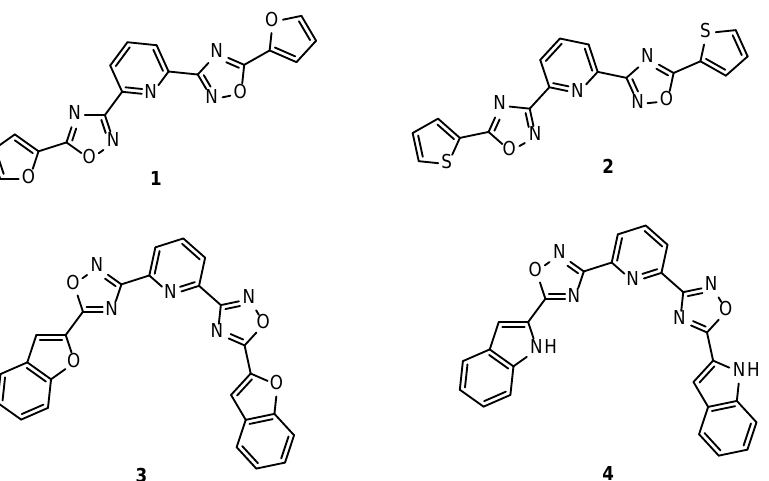
Figure 4. Examples of compounds based on 1,2,4-oxadiazole units ( 1 ) 2,6-bis(5-furan-2yl)-1,2,4-oxadiazol-3-yl)pyridine; ( 2 ) 2,6-bis(5-(thiophen-2yl)-1,2,4-oxadiazol-3-yl)pyridine; ( 3 ) 5-(benzofuran-2-yl)-3-(6-(5-(2,3-dihydrobenzofuran-2yl)-1,2,4-oxadiazol-3-yl)pyridin-2-yl)-1,2,4-oxadiazole; ( 4 ) 3-(6-(5-(1H-indol-2-yl)-1,2,4-oxadiazole-3-yl)pyridin-2-yl)-5-(indolin-2-yl)-1,2,4-oxadiazole